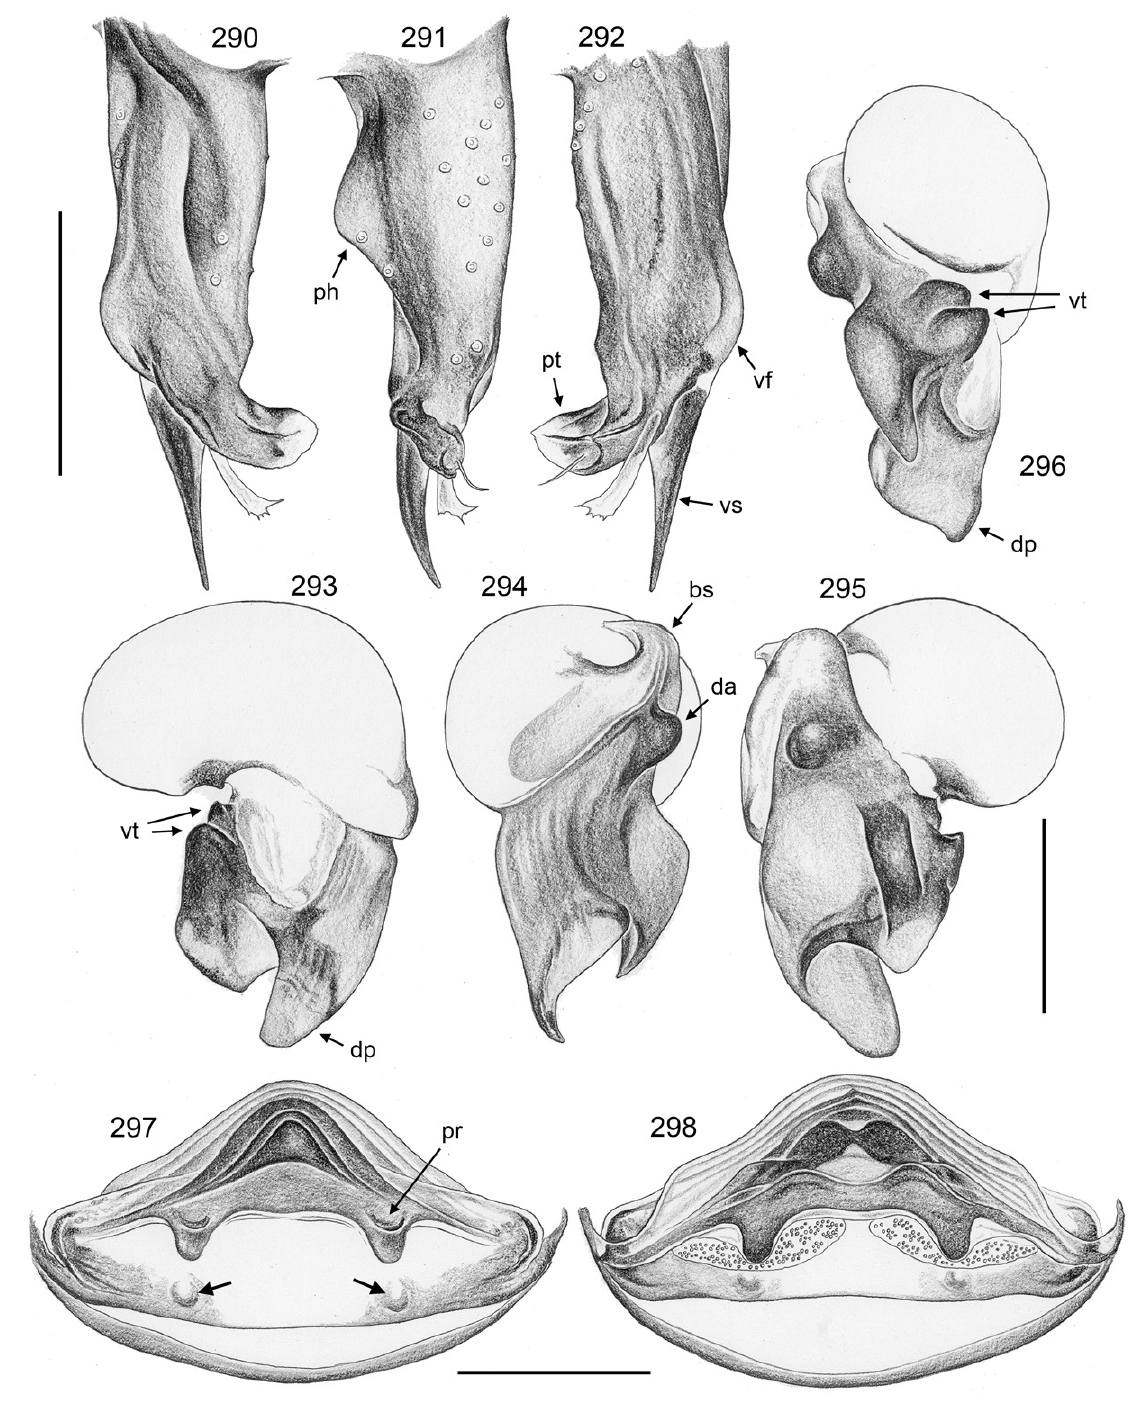
Figs 290–298. Maghreba aurouxi (Barrientos, 2019) gen. nov.; male and female from Morocco, SE of Zebzat (ZFMK Ar 22385, Ar 22386). 290–292 . Left procursus, prolateral, dorsal, and retrolateral views. 293–296 . Left genital bulb, prolateral, dorsal, retrolateral, and ventral views. 297–298 . Cleared female genitalia, ventral and dorsal views; arrows: pockets (pits). Abbreviations: bs = basal sclerite; da = dorsal apophysis; dp = dorsal process; ph = prolateral hump; pr = epigynal process; pt = procursus tip; vf = ventral flap; vs = ventral sclerite; vt = ventral teeth. Scale bars = 0.3